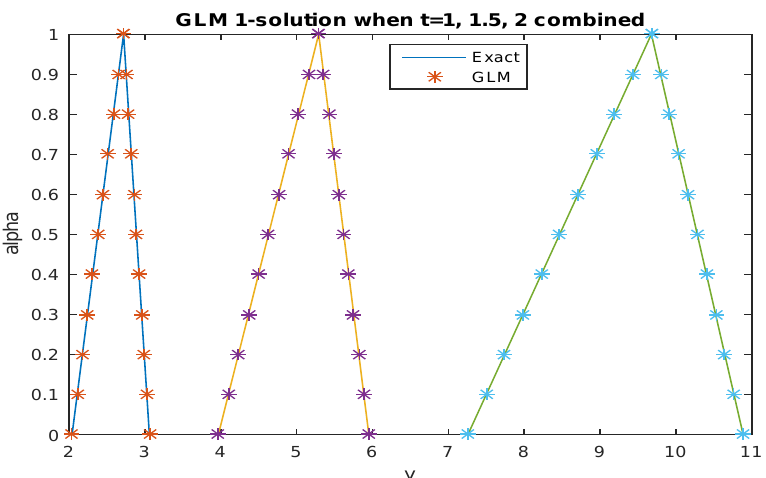
Figure 4. Exact(line) and GLM 1-solutions(stars) for Example 1 when t = 1.0, 1.5 and 2.0 with triangular fuzzy numbers as the initial conditions.